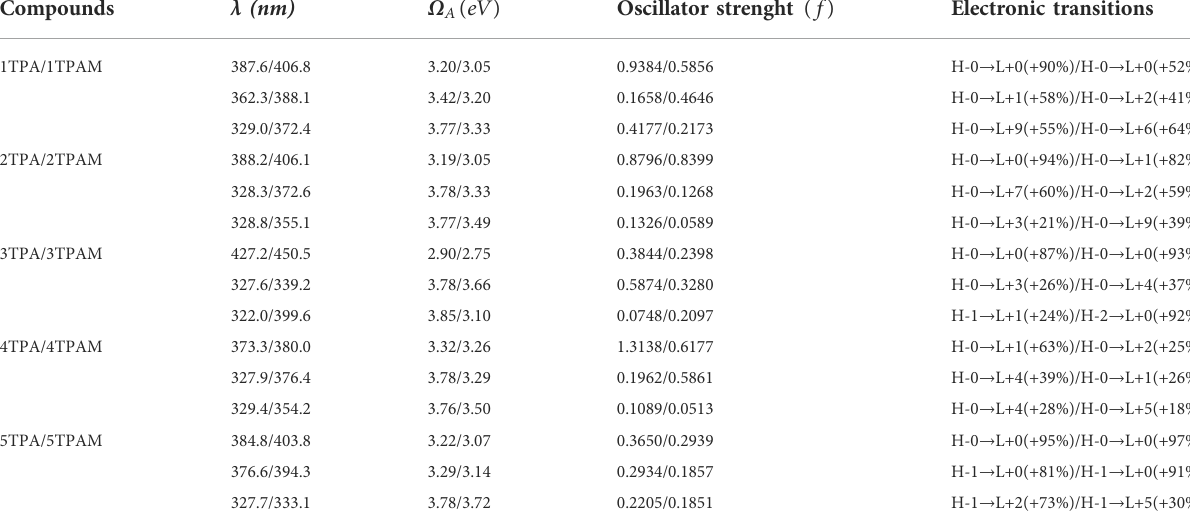
TABLE 3 Maximum absorption wavelengths ( λ ), vertical absorption energy ( Ω A ), oscillator strength ( f ) and the main electronic transitions of triphenylamine derivatives calculated with M06/6-311++G(d,p). Compounds λ (nm) Ω A ( eV ) Oscillator strenght ( f ) Electronic